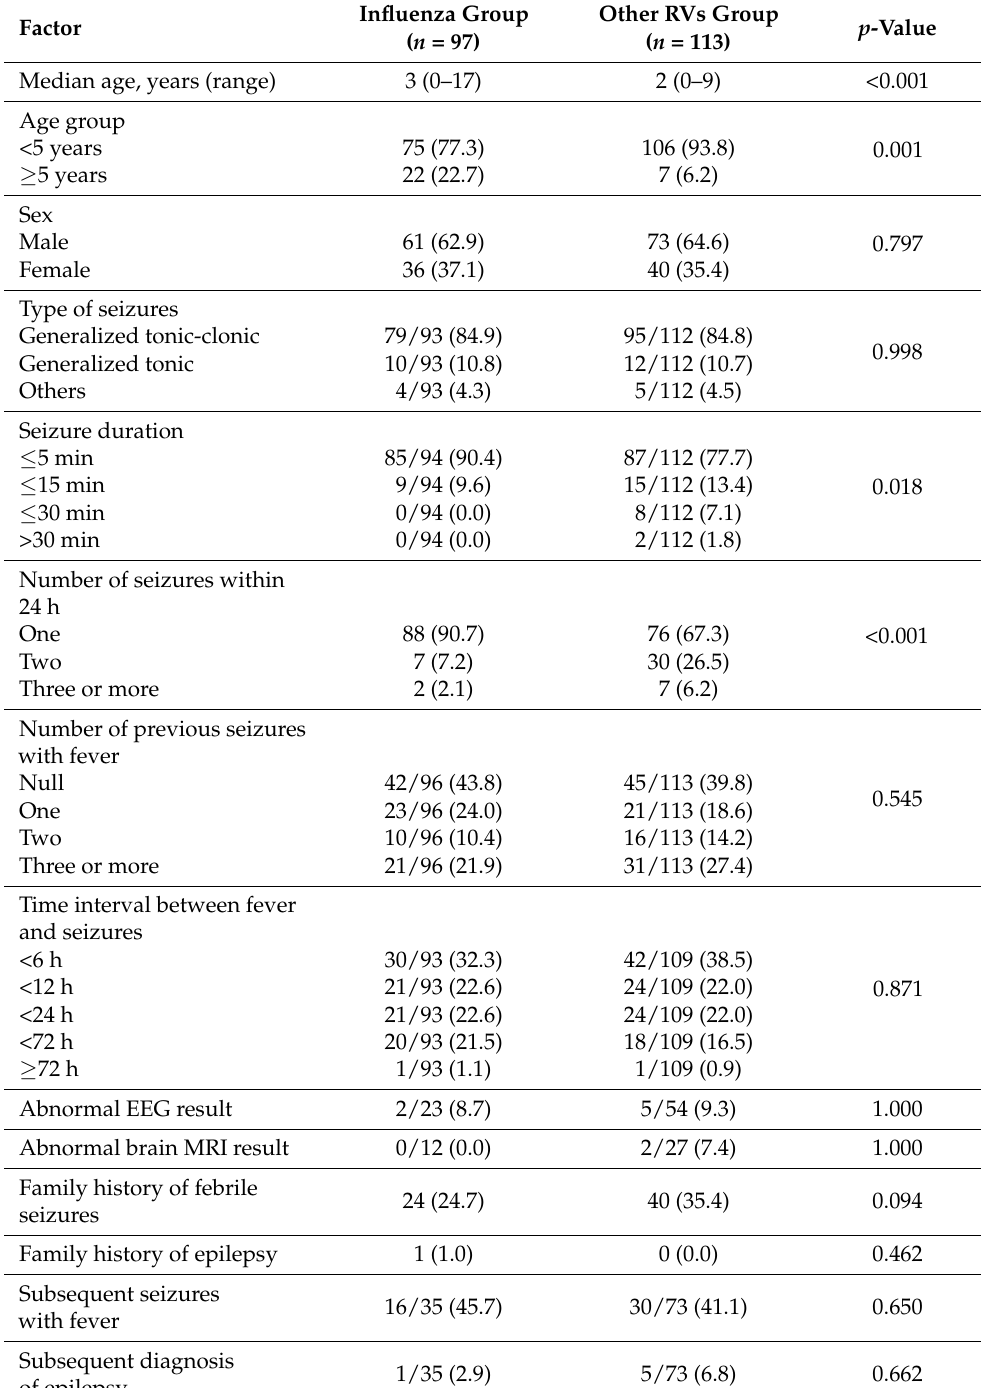
Table 1. Comparison between the influenza and other respiratory viruses